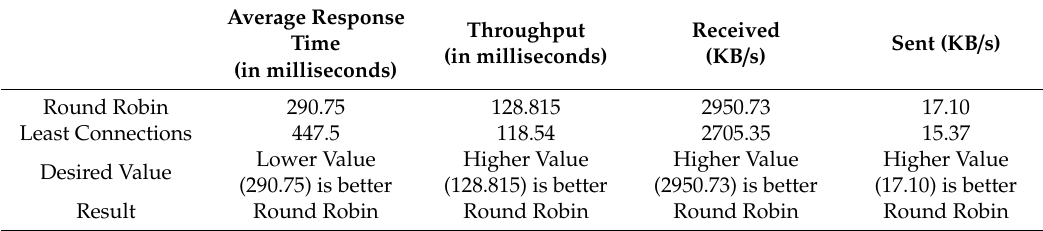
Table 8. The summarized comparison result of the round robin and least connections